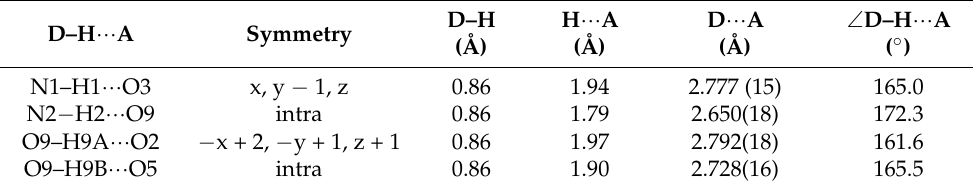
Figure 3. Packing diagram of DBH with 30% probability thermal ellipsoids. 3.2. Vibrational Analysis As shown in Figure 4, the ν O − H vibration appeared at 3383 cm − 1 in the infrared spectra and at 3388 cm − 1 in DFT calculations, which is due to the water of DBH . The ν C − H vibration of the 5,6-dimethyl-1H-benzo[d]imidazole ring appeared at 3106 cm − 1 , and the corre- sponding calculated band was observed at 3126 cm − 1 . The calculated and experimental ν C=O vibrations of the 1,3-dioxane ring were observed at 1737 cm − 1 and 1629 cm − 1 and at 1691 cm − 1 and 1652 cm − 1 , respectively. The ν C–O bands of 1,3-dioxane ring were seen at 1261 cm − 1 and 1225 cm − 1 in DFT and at 1255 cm − 1 and 1215 cm − 1 in the IR spectra, respectively. These values agree well with literature reports (22 − 24) . The ν C=N and ν C–N vibrations occurred at 1490 cm − 1 and 1347 cm − 1 in DFT, respectively. The corresponding bands were seen at 1489 cm − 1 and 1366 cm − 1 in the IR spectra. In a word, the IR spectra for DBH agree very well with the calculated values.